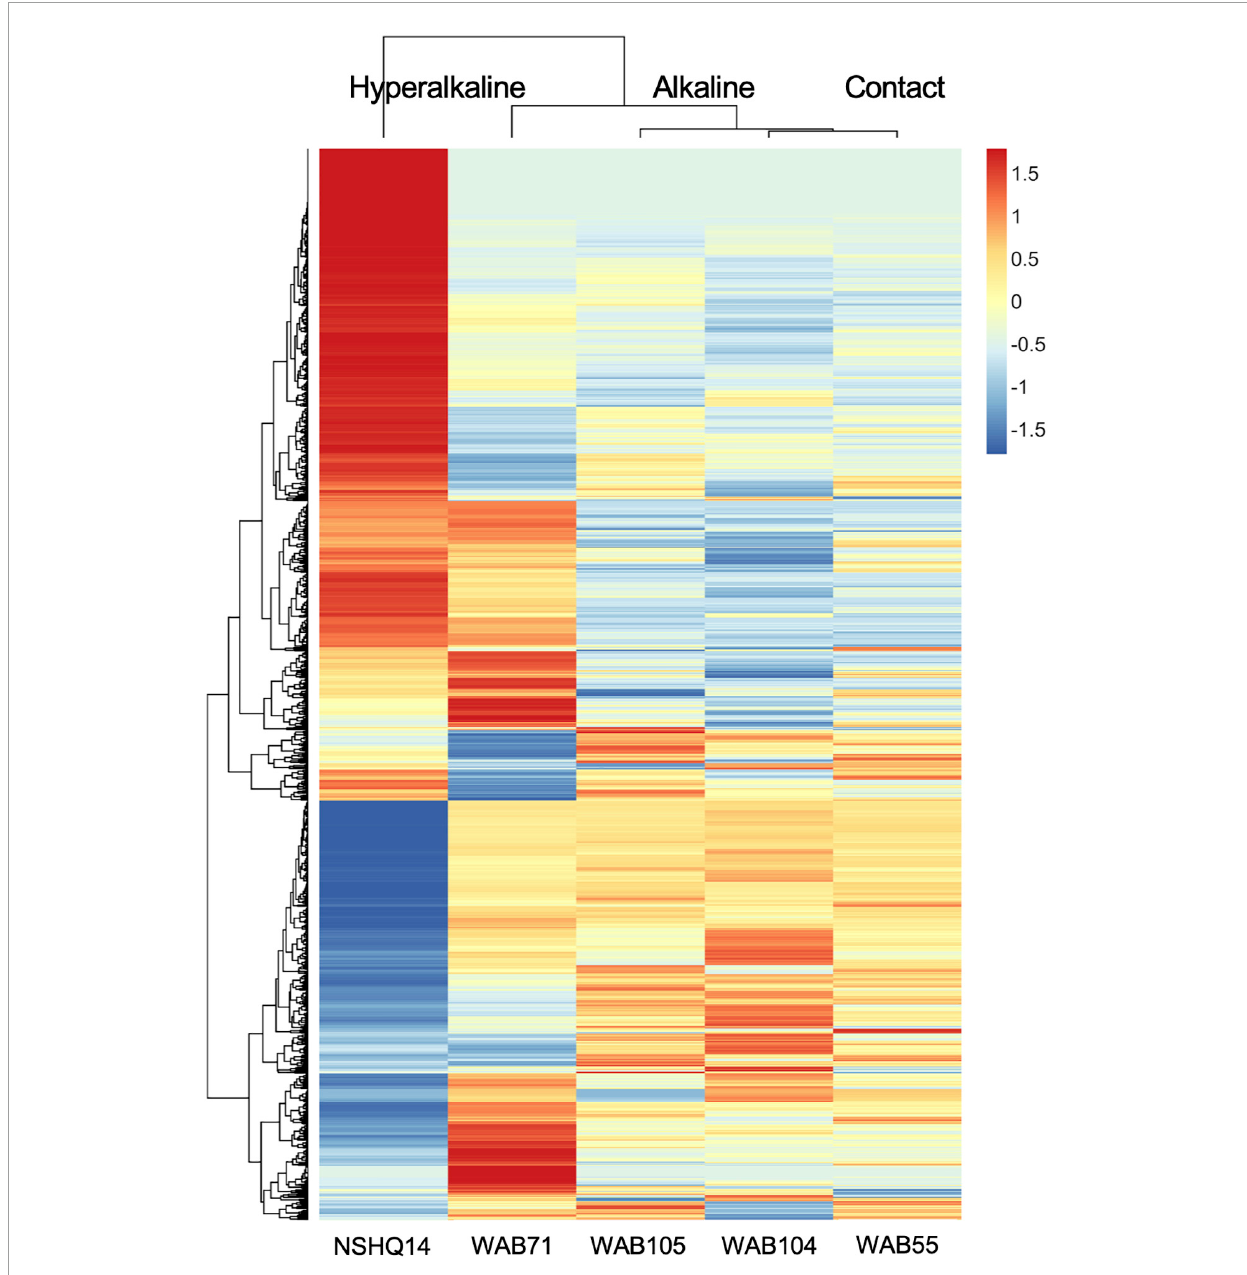
FIGURE2 Z-scores of metabolomic feature abundance across wells clustered using a Pearson correlation, indicate peaks in the mass spectrometry data are differentially more abundant in some wells than in others. In particular, NSHQ14 had many unique features, most of which could not be